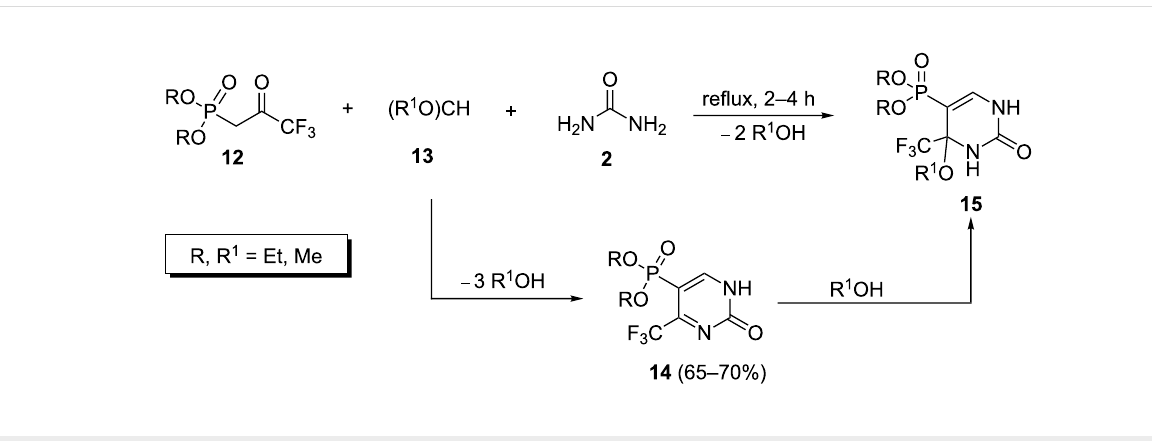
Scheme 4: Biginelli reaction of dialkyl (3,3,3-trifluoropropyl-2-oxo)phosphonate with trialkyl orthoformates and urea.